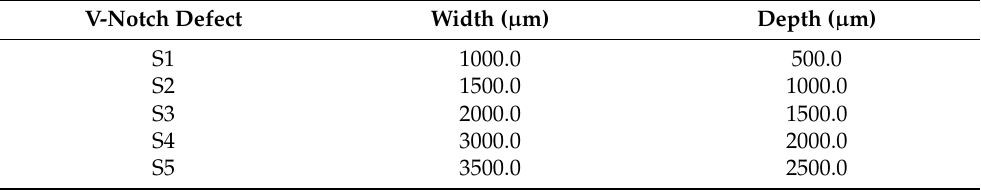
Table 1. Dimensions of five V-shaped notches on the surface of an ASTM-A36 steel